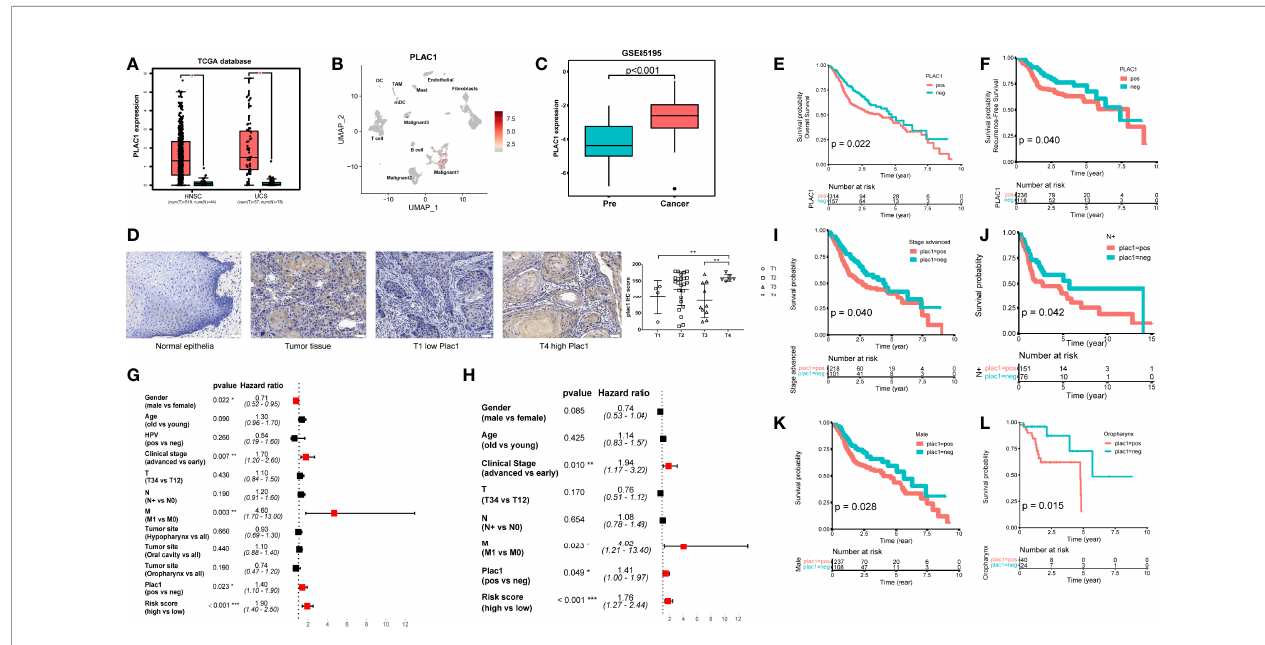
FIGURE 1 | Plac1 expression patterns. (A) The expression status of plac1 in tumor and normal tissues in head and neck squamous cell carcinoma (HNSC) and uterine carcinosarcoma. (B) The plac1-positive cell distribution pattern in HNSC based on single-cell sequencing data from GSE103322. (C) The plac1 expression status in pre-cancer and cancer stage during HNSC tumorigenesis based on data from GSE85195. (D) Images of immunohistochemistry (IHC) staining for plac1 in normal epithelia tissues and tumor tissues with different T stages. Scale bars: 50 um. The Plac1 IHC score is higher in T4 stage compared to those in other T stages (right). (E, F) Correlation between plac1 expression and survival prognosis in The Cancer Genome Atlas-HNSC database. The survival probability of overall survival (OS) (E) and recurrence-free survival (F) , respectively, are shown. If not mentioned speci fi cally, survival probability represents overall survival. (G, H) Univariate (G) and multivariate (H) Cox regression analysis of HNSC for clinical factors. (I – L) Correlation between plac1 expression and OS in advance-stage cancer patients (I) , lymph node metastasis patients (J) , male patients (K) , and oropharynx cancer patients (L) , respectively. * p < 0.05, ** p < 0.01, *** p <